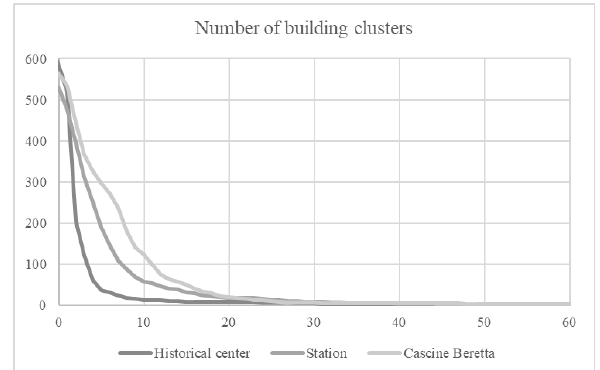
Figure 5 . Graph showing the reduction in clusters number at every buffer iteration (Biraghi, 2019)